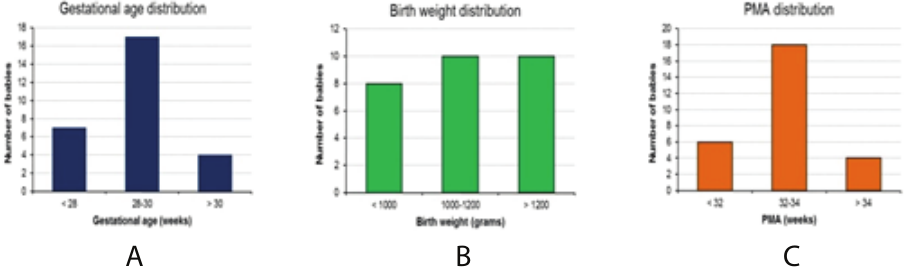
Figure 2. Column chart showing number of babies according to gestational age (A), birth weight (B), and PMA (C).